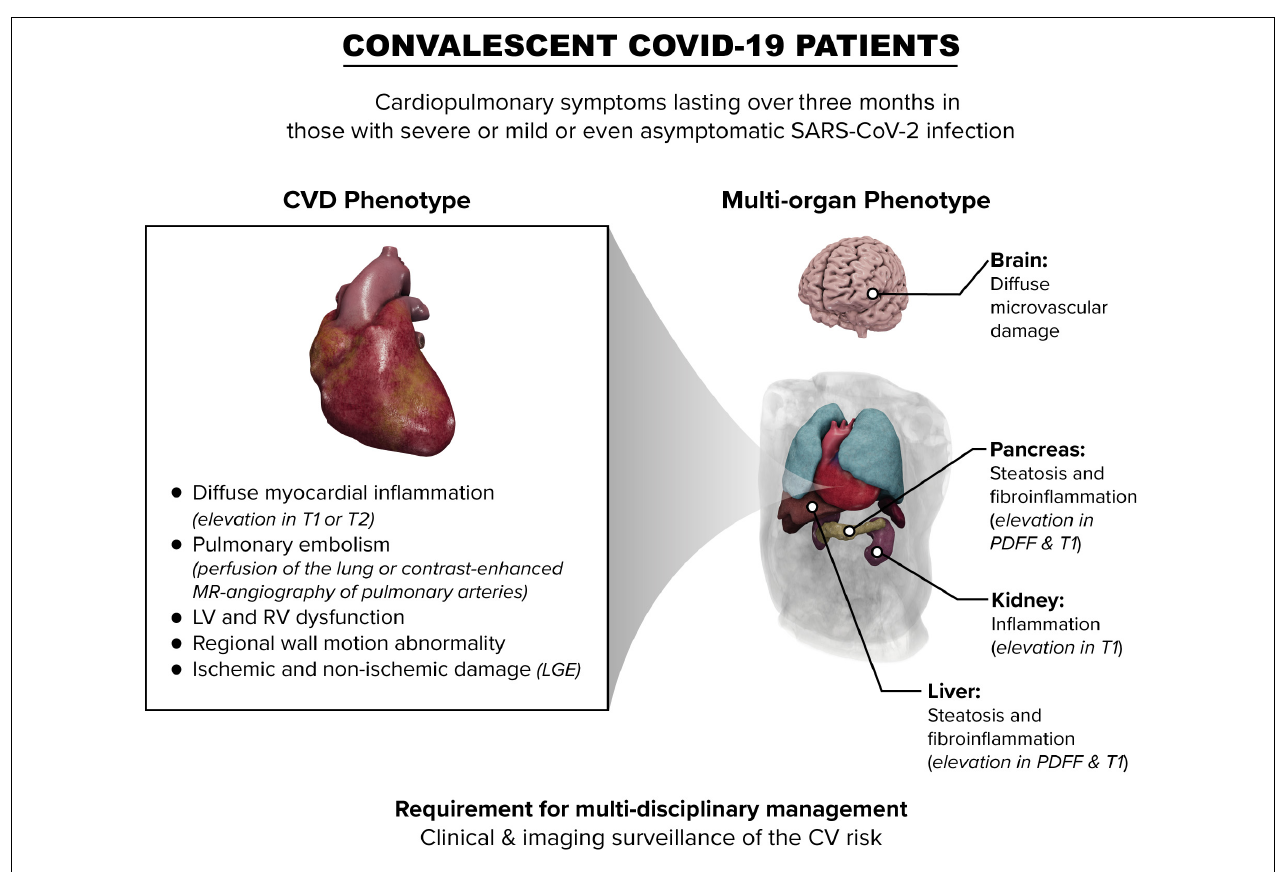
FIGURE 1 | Schematic overview of the impact of COVID-19 on the heart and other organs in convalescent patients. LV, left ventricle; RV right ventricle; CV cardiovascular; LGE, late gadolinium enhancement; PDFF, proton density fat fraction.